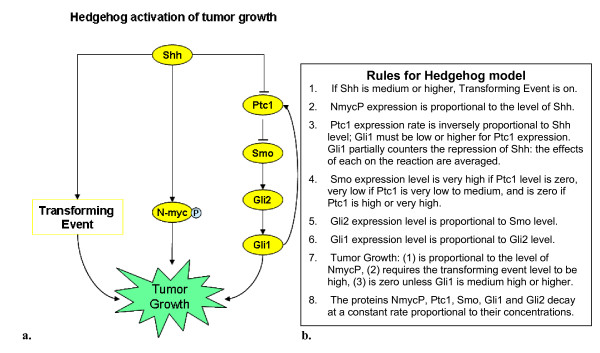
a. A schematic diagram of hedgehog regulation of tumor growth in the cerebellum is shown. These proteins are key components of the hedgehog signaling pathway, though many intermediate enzymes may mediate some steps. The "transforming event" is hypothesized to be required for tumor growth, but details about its function are completely lacking [61]. Tumor growth is a macroscopically defined process that is connected to molecular dynamics using rules. b. The rules for this model are given in linguistic form, much as they might be described in journal articles that discuss this pathway.